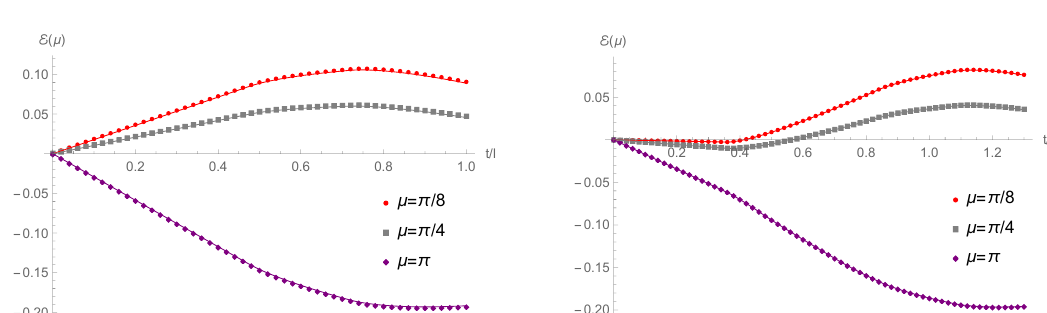
, π , π . Right panel: disjoint intervals with L = 8 3 2 , π , π . As shown in the figure, the agreement is 10 5 2